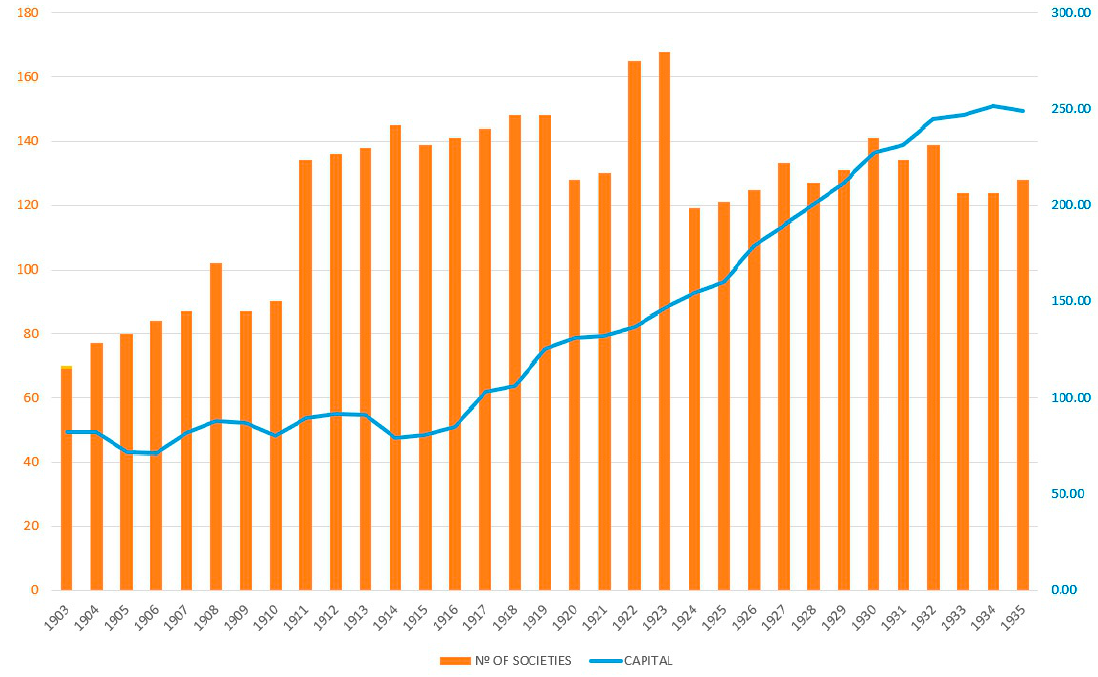
Figure 9. Capitals and number of water companies in Spain (1903–1935).